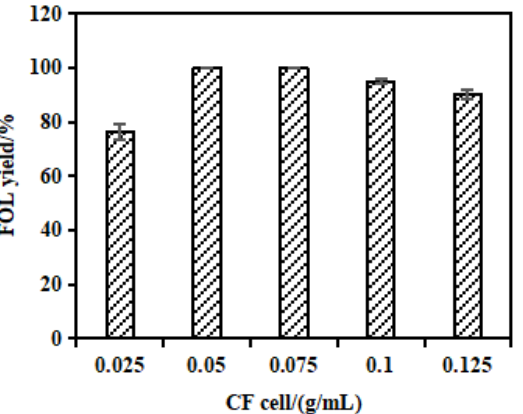
Figure 4. The effect of CF cell dosage on the FOL yield (150 mM FAL, 35 °C, pH 7.5, 0.50 mM Sn 4+ , 8 h).